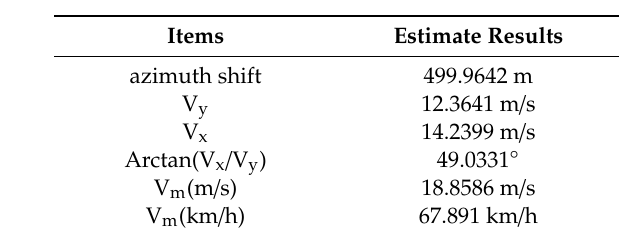
Table 6. Processing results.